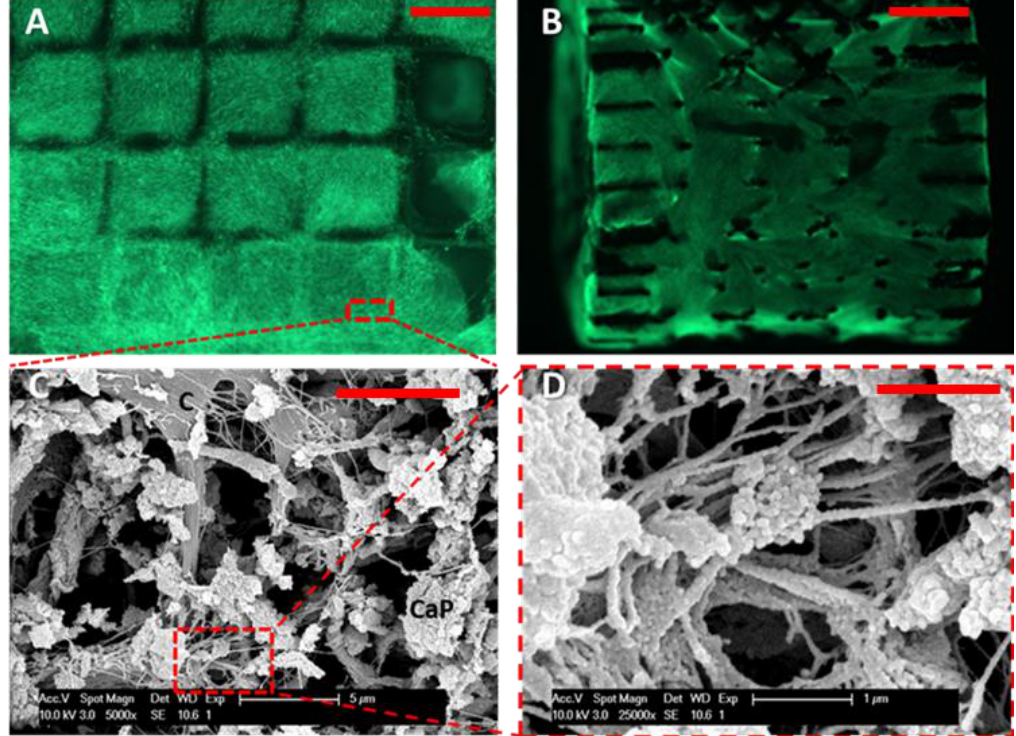
Figure 3. In vitro -engineered three-dimensional (3D) osteogenic tissue-engineering (TE) constructs using porous Ti6Al4V scaffolds in a perfusion bioreactor culture (Experimental Condition B4). ( A ) Close-up live/dead image (pore size: 800 µm); ( B ) live/dead image showing the distribution of cells throughout the construct (scale bar: 1 mm); ( C ) SEM micrograph, showing cell and extracellular matrix micromorphology at the void for a representative bioreactor condition (B4) (a magnification of 5000× was used; scale bar: 5 µm); ( D ) SEM micrograph showing mineralization of extracellular fibers. (SEM, scanning electron microscopy; C, cell; CaP, mineral grains; extracellular matrix fibers are also